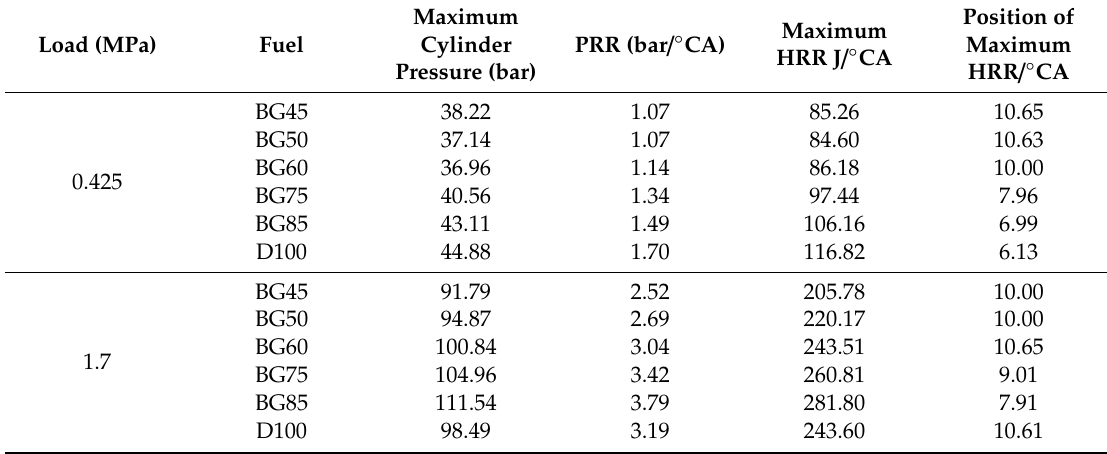
Figure 10. Variations of HRR with crank angle for diesel and biogas-diesel fuels. ( a ) BMEP = 0.45MPa, ( b ) BMEP = 1.7MPa.